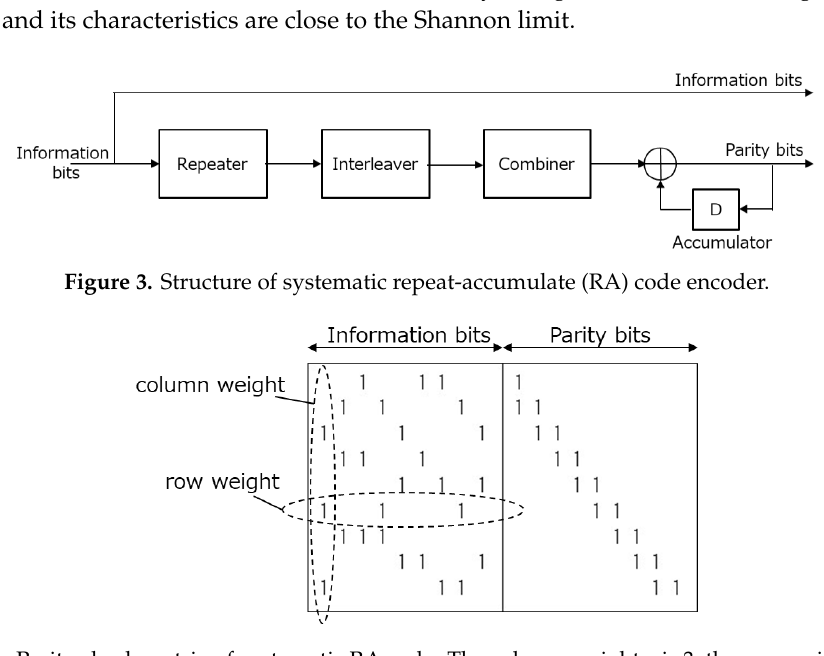
Figure 4. Parity check matrix of systematic RA code. The column weight 𝑞 is 3, the row weight 𝑟 is 3.